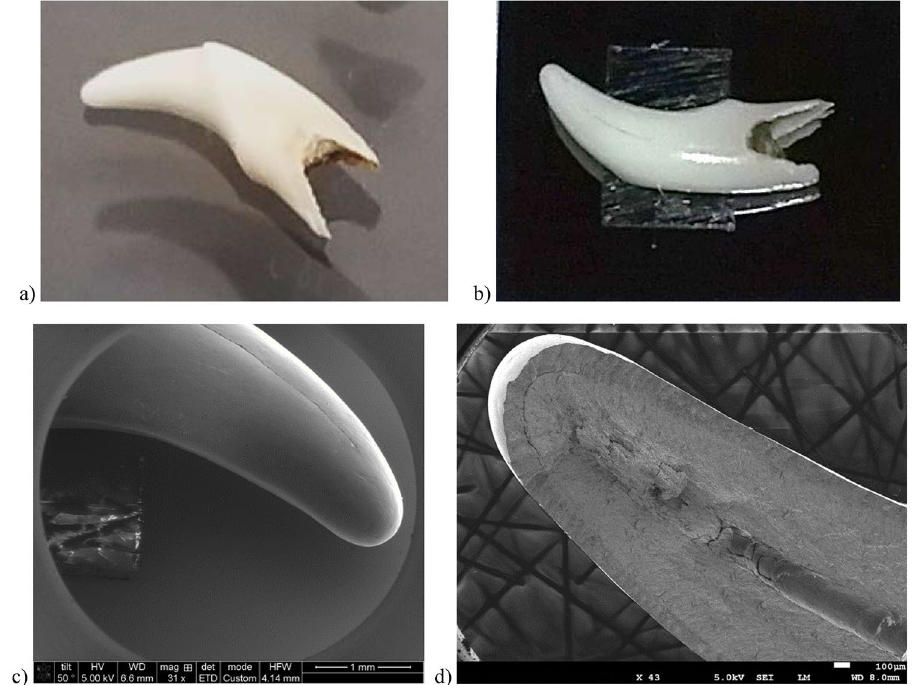
Figure 1. Optical and scanning electron micrographs of SiS ZnO treated tooth sample. ( a ) Photo of tooth sample before fixing on silicon piece carrier. ( b ) Photo of tooth sample after SiS ZnO treatment, showing double sided carbon tape underneath. ( c ) Tooth tip imaged prior to breaking open the tooth along observable crack. ( d ) Same tip after breaking open tooth along crack